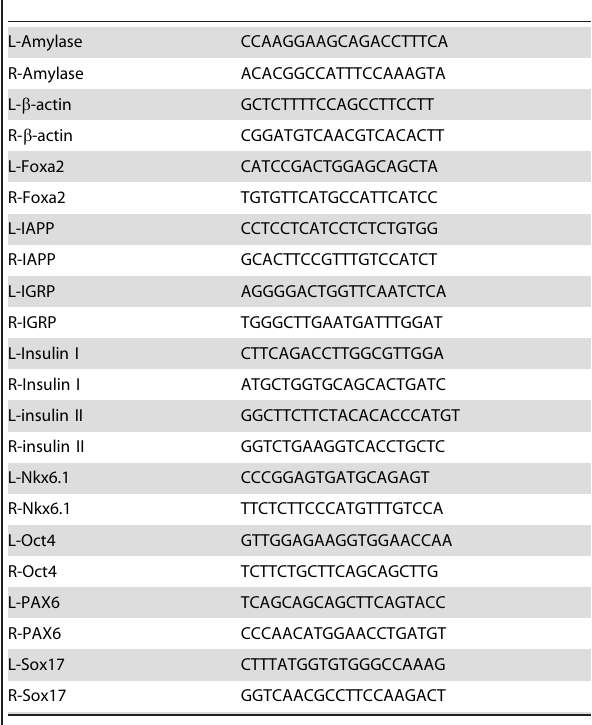
Table 1. A list of primers for the various